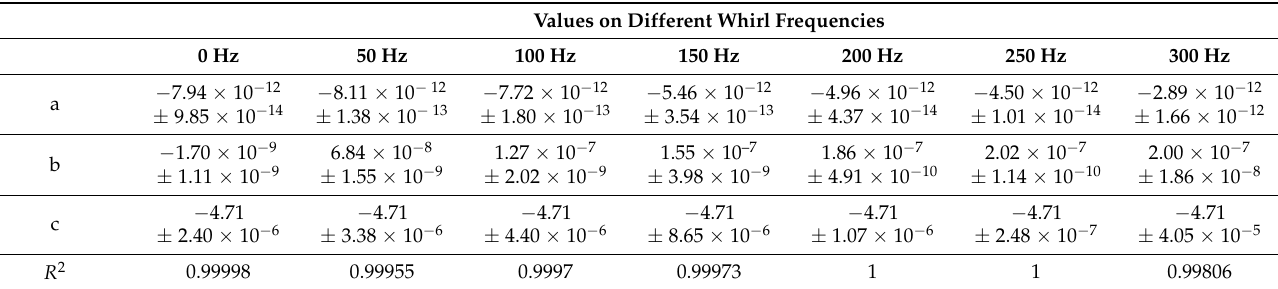
Table 3. Constant terms and R 2 values at different whirl frequencies. Values on Different Whirl